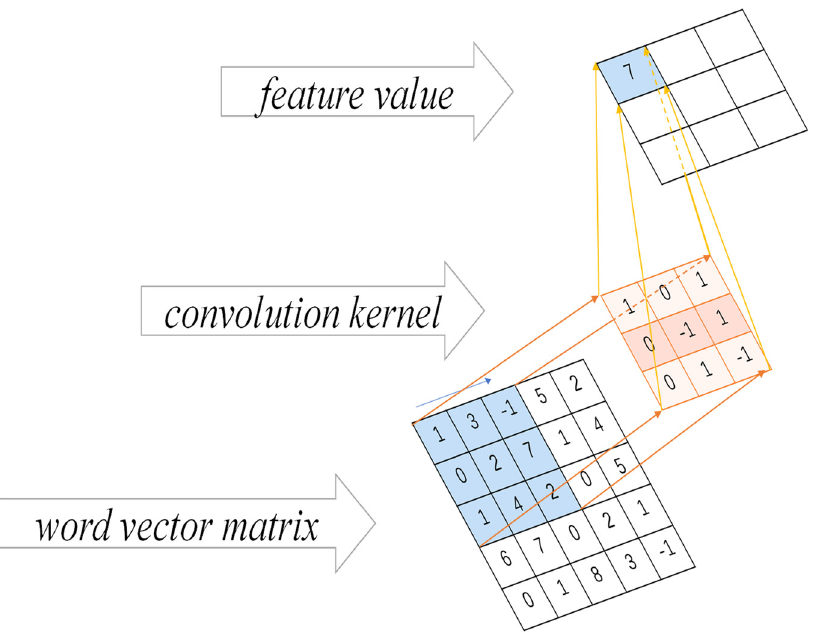
Figure 4. The diagram of convolution operation.